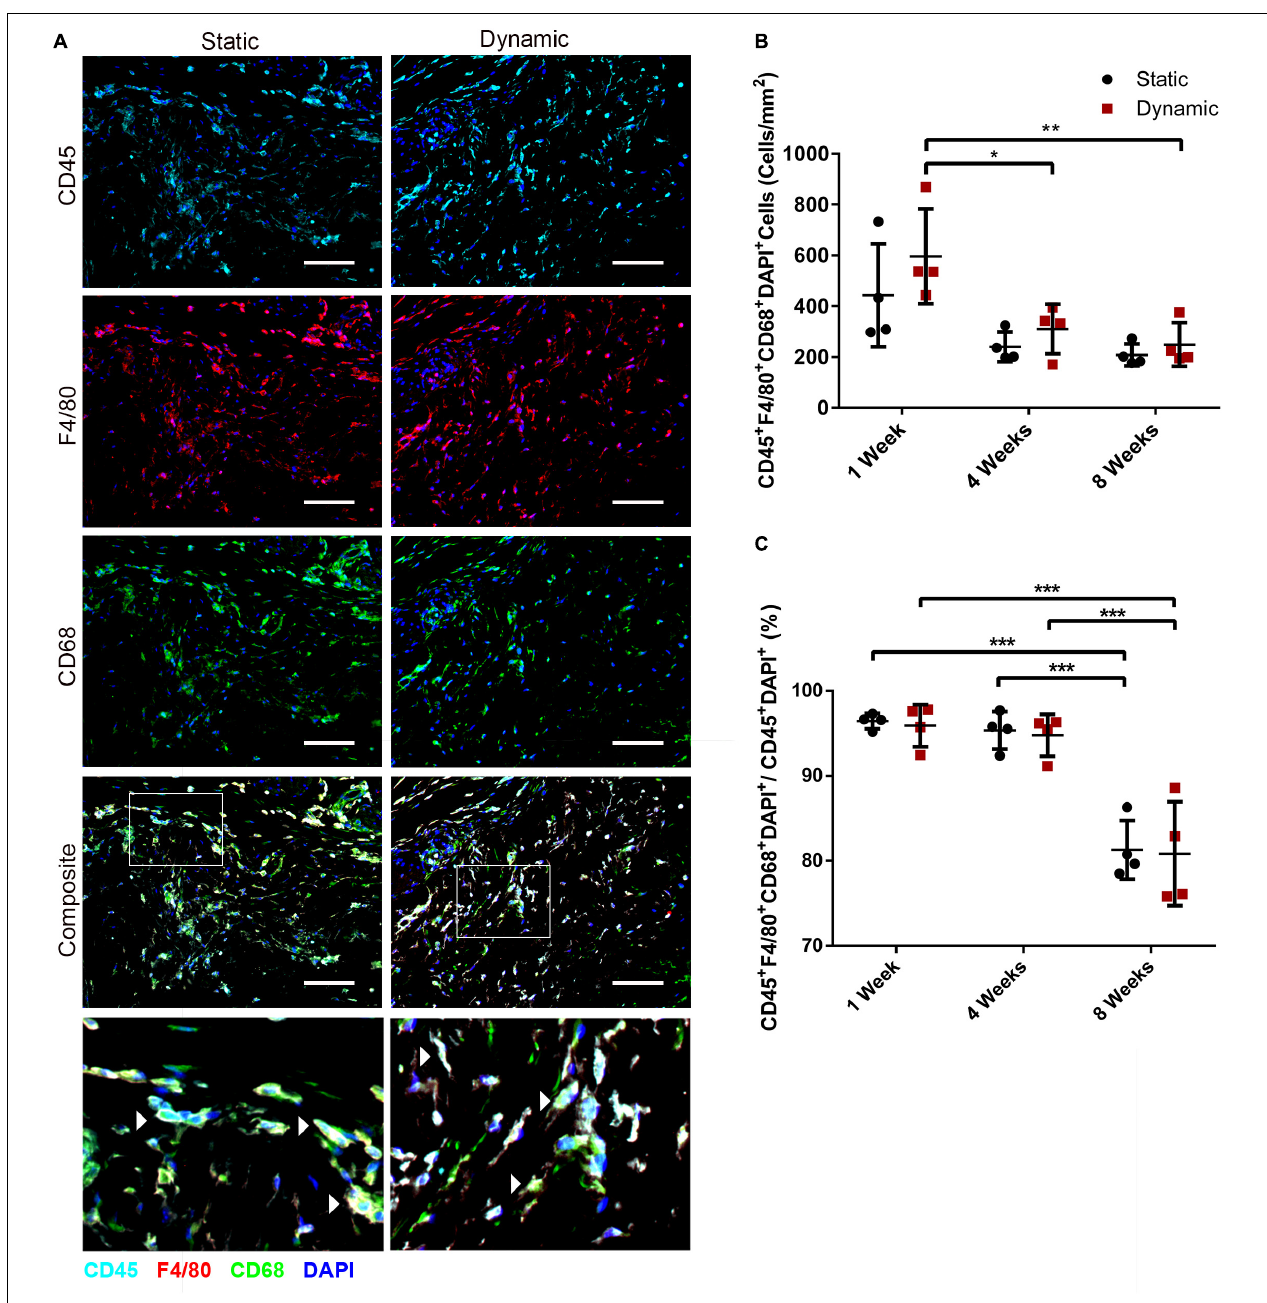
FIGURE 6 | The recruitment of CD45 + F4/80 + CD68 + macrophages was similar in the ASC-seeded DAT scaffolds that were cultured dynamically and statically for 14 days prior to implantation in the nu/nu mouse model. (A) Representative images showing CD45 (cyan), F4/80 (red), and CD68 (green) expression with DAPI counterstaining (blue) at 1-week post-implantation. Scale bars represent 100 µ m. Boxed regions in the composite images are shown at higher magnification below. White arrowheads highlight CD45 + F4/80 + CD68 + DAPI + cells. (B) CD45 + F4/80 + CD68 + DAPI + cell density in the static and dynamic groups. (C) The percentage of CD45 + F4/80 + CD68 + DAPI + cells relative to the total CD45 + DAPI + cell population at 1, 4, and 8 weeks. * p < 0.05, ** p < 0.01, *** p <